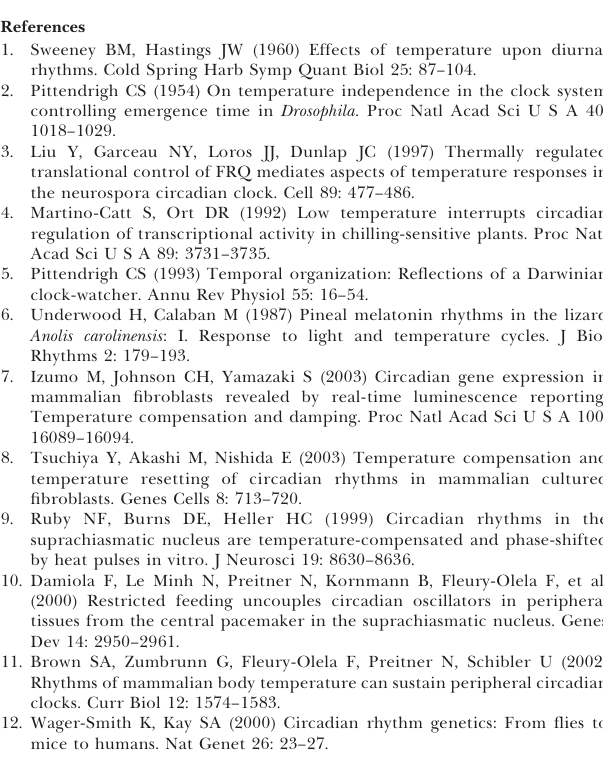
Figure S2. Temperature Steps Induce Changes in Luciferase Reporter mRNA Expression